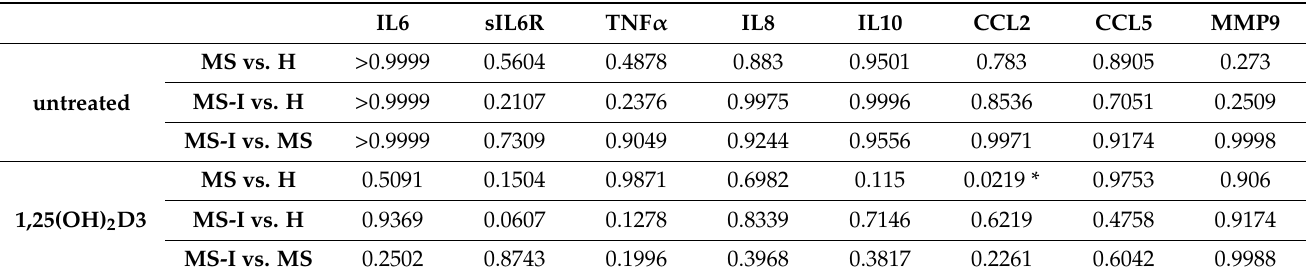
Table 2. Adjusted p values of the indicated comparisons of soluble mediators secreted in IL4-culture supernatants (Tukey’s